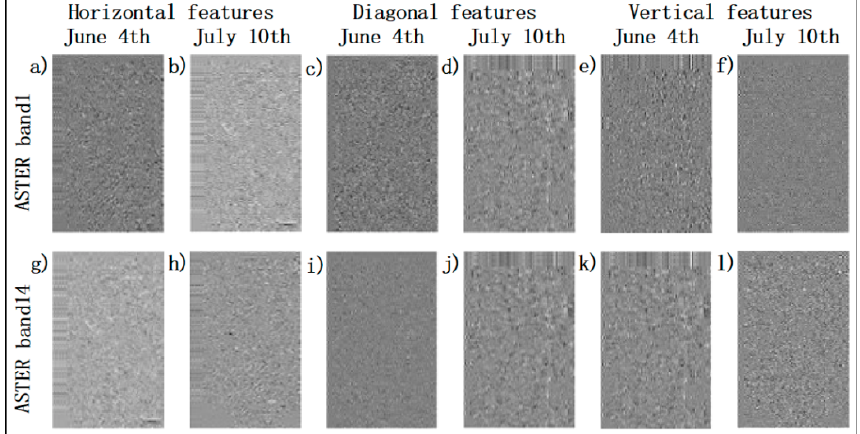
Figure 3. The wavelet decomposition results of ASTER band 1 and band 14 images from 4 June and 10 July 2008 at three directions by the discrete wavelet transform (DWT): ( a , b , g , h ) horizontal features; ( c , d , i , j ) diagonal features; and ( e , f , k , l ) vertical features. Retrieval of Land Surface Component